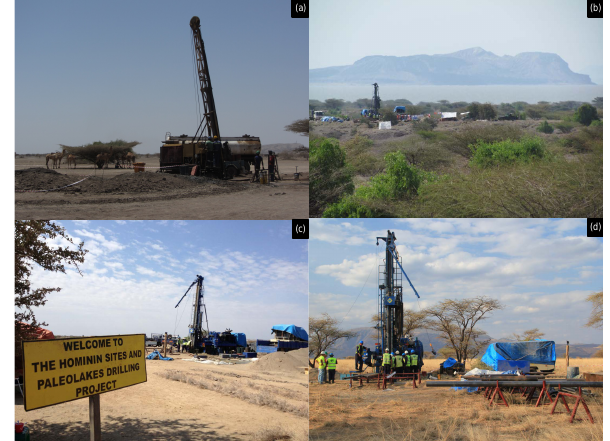
Figure 3. HSPDP drilling operations: (a) Lake Magadi drill site (MAG14) in the southern Kenya Rift Valley. Crystalline trona on the dry Magadi pan visible in the foreground (photo A. Co- hen); (b) Chew Bahir drill site (CHB14) in the southern Ethiopian Rift Valley, Hammar Range in the background (photo A. Cohen); (c) HSPDP presentation to the local community group by National Museums of Kenya personnel at the Tugen Hills drill site (photo courtesy of National Museums of Kenya); (d) filmmaker Doug Prose of Earth Images Foundation filming tephra outcrops in the Omo River Valley, near the Chew Bahir drill site (photo A.